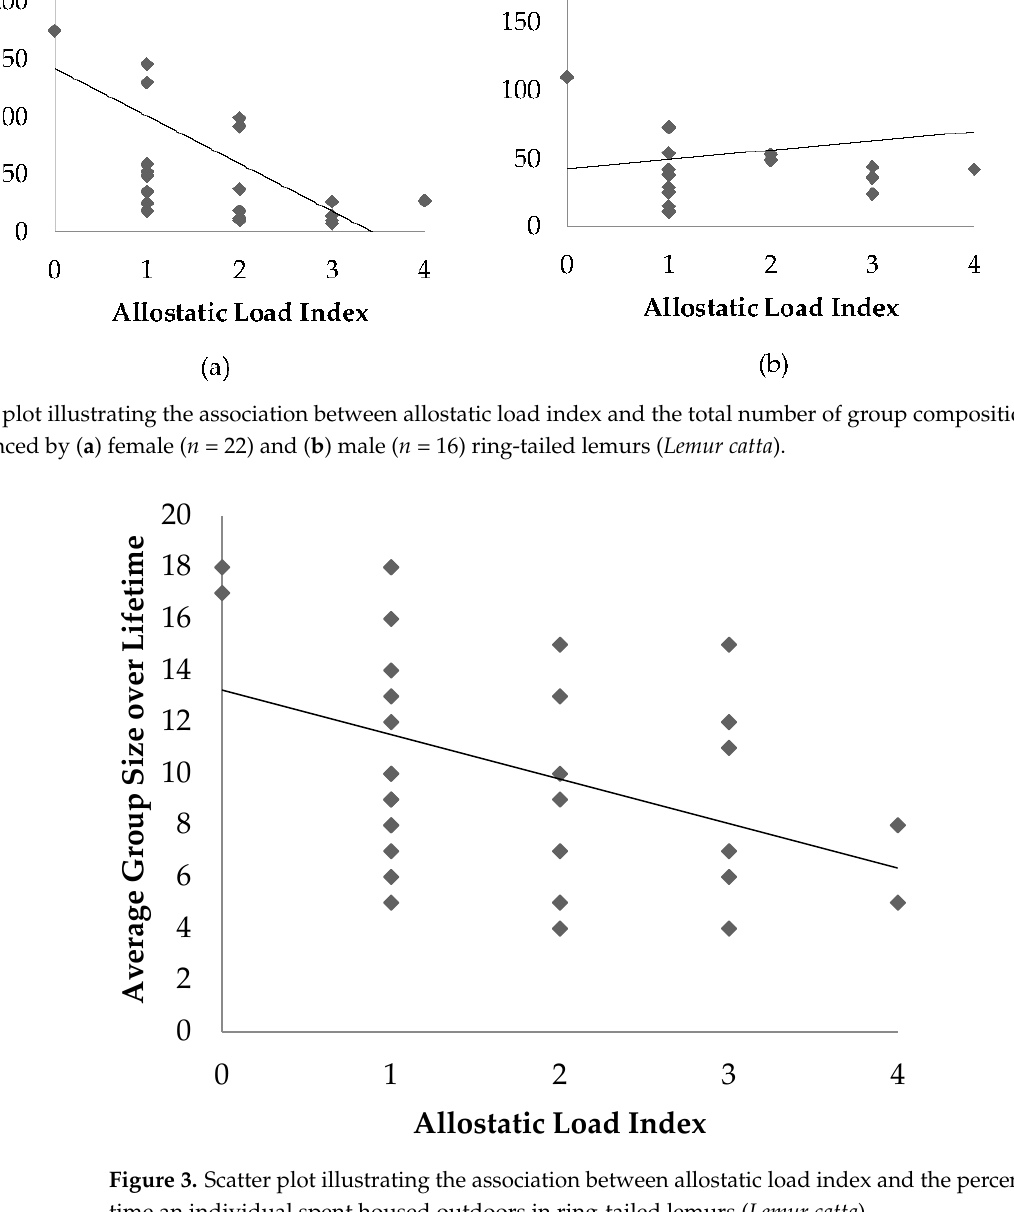
Figure 3. Scatter plot illustrating the association between allostatic load index and the percentage of time an individual spent housed outdoors in ring-tailed lemurs ( Lemur catta ).